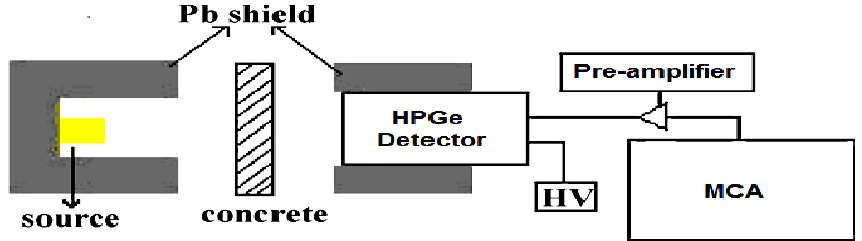
Figure 2. The schematic diagram of experimental setup of narrow beam